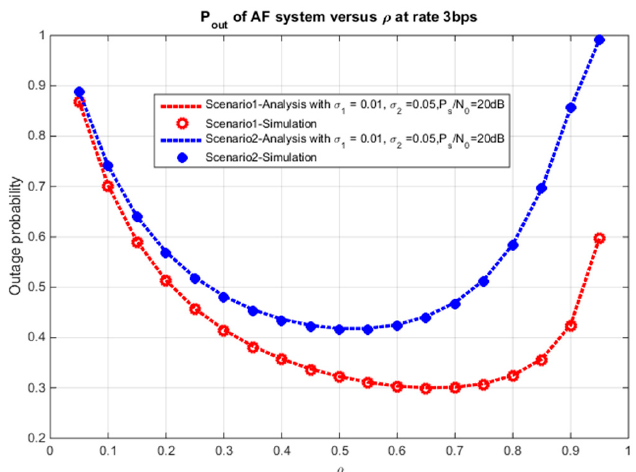
Figure 7. The outage probability versus ρ for the PS protocol.